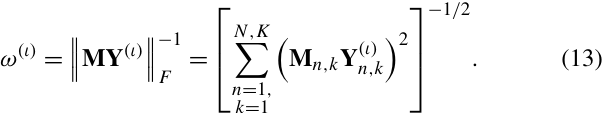
Fig. 2b, Alg. 3 employs a CV methodology to choose the optimum tuning parameters for inferring the WV ϕ and attenuated backscatter χ . Fig. 2c, Alg. 4 infers the WV ϕ and attenuated backscatter χ for a fixed tuning parameter via a coarse-to-fine image resolution